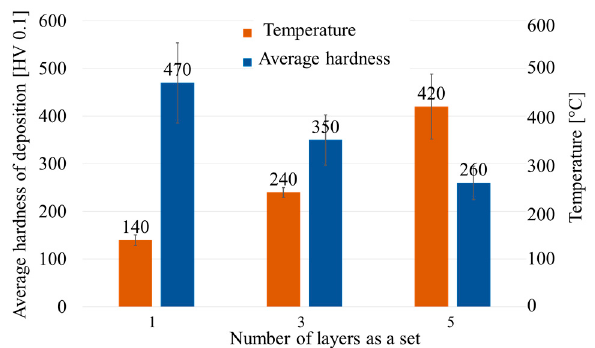
Figure 19. Average hardness of volumes built with different build-up strategies and maximum surface temperature achieved while the deposition process.